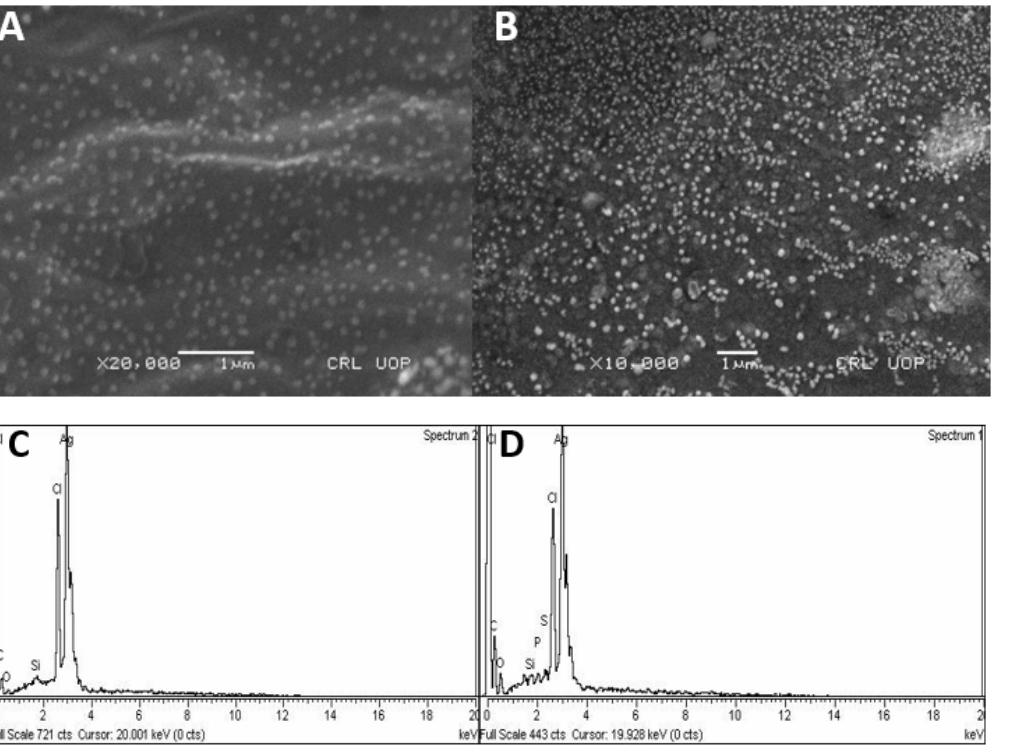
Figure 6. Micrographs of SEM analysis of leaf-capped AgNPs ( A ) and bulb-capped AgNPs ( B ) at 1 µm magnification. EDX of leaf-capped AgNPs ( C ) and bulb-capped AgNPs ( D ).